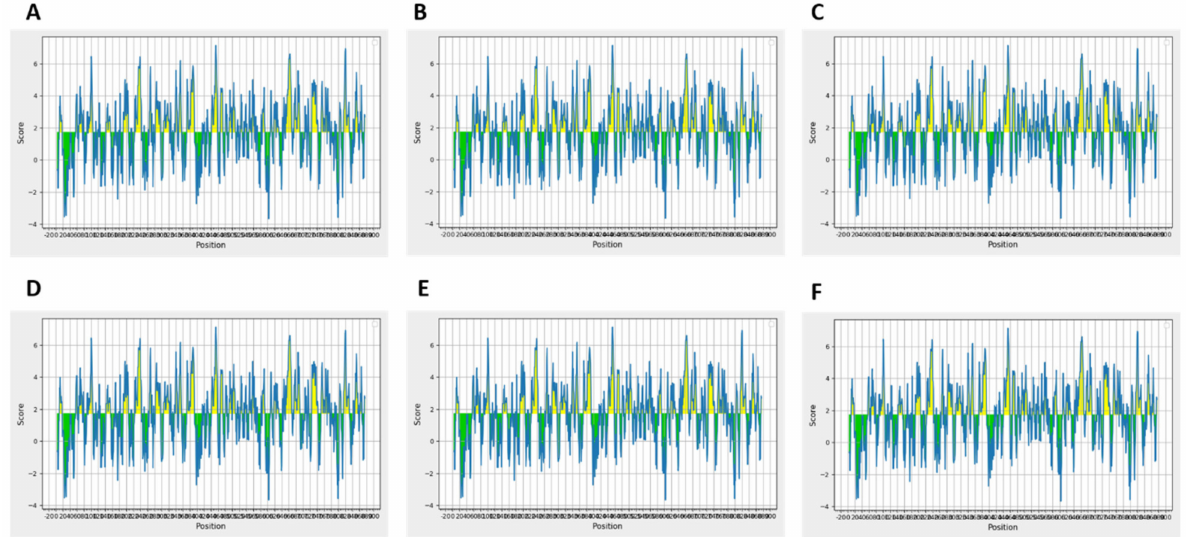
Figure 2. B-cell epitope analysis. ( A ) Bepipred linear epitope. ( B ) Chou and Fasman beta-turn prediction. ( C ) Emini surface accessibility prediction. ( D ) Karplus and Schulz flexibility prediction. ( E ) Kolaskar and Tongaonkar antigenicity. ( F ) Parker hydrophilicity